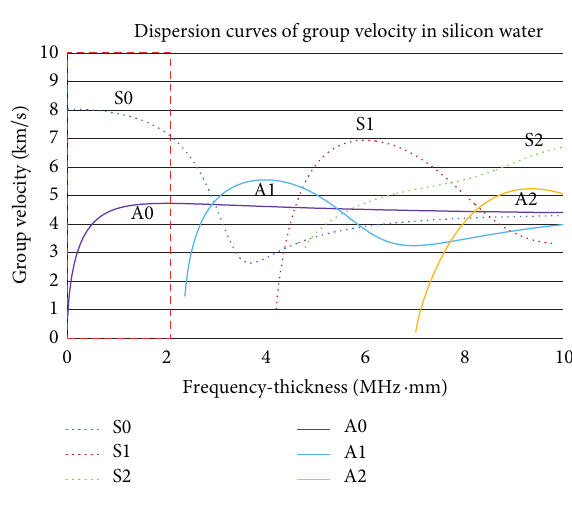
Figure 1: Dispersion curves of group velocity in silicon wafers whose thickness is 525 𝜇